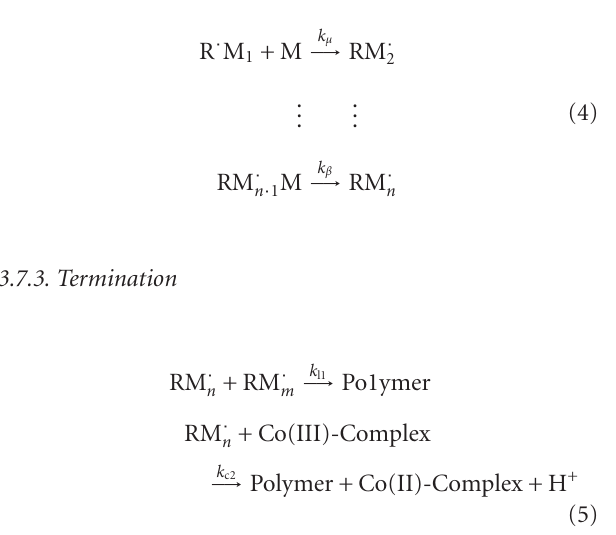
Figure 6: Biodegradation by activated sludge of (a) PAN, (b) PAN/MMT (5%w/v) on time versus weight